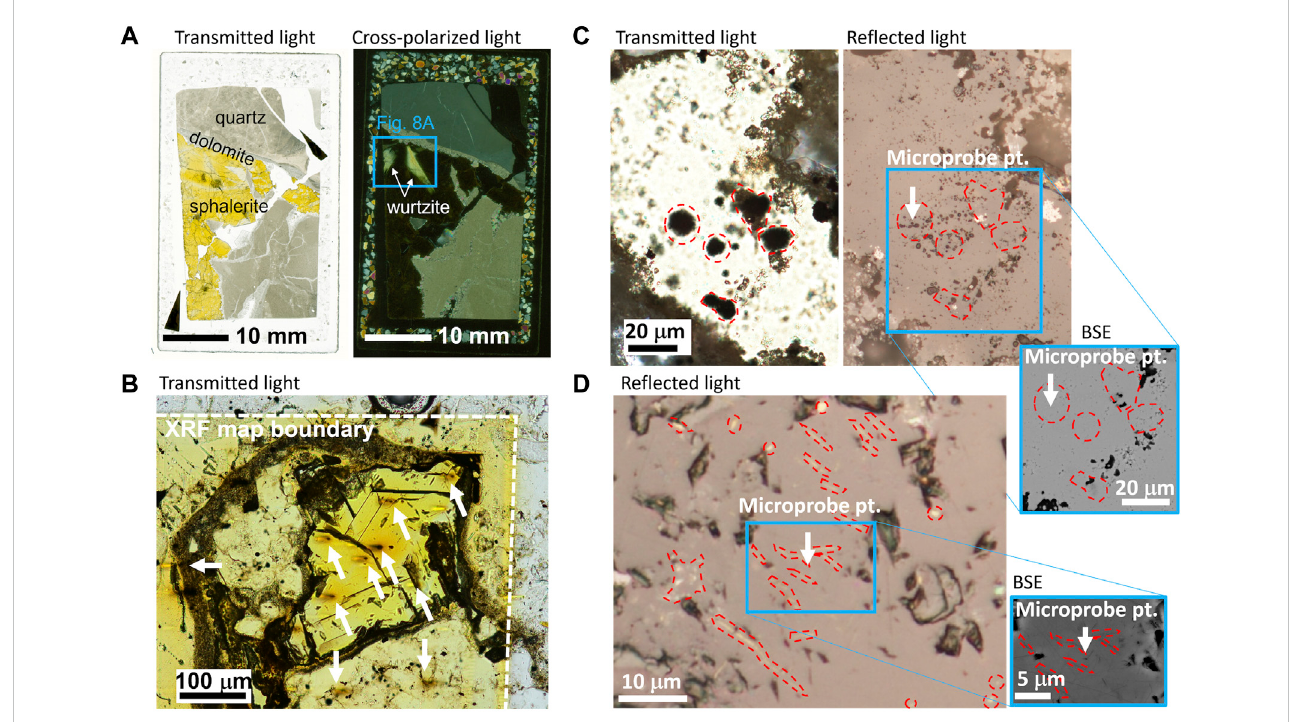
FIGURE 2 Applications of optical microscopy. (A) Transmitted light image showing the distribution of minerals in this sample. Sphalerite color varied from clear to golden yellow. A cross-polarized transmitted light image of the same sample revealed the distribution of anisotropic regions, which indicate the presence of non-cubic ZnS. (B) Transmitted light image collected post-synchrotron in order to document changes induced by the synchrotron X-ray beam. Note yellowing of the entire μ -XRF map region. Also note dark orange marks where XANES spectra were collected (white arrows). Although potentially indicatingbeamdamage,nochangeswereobservedinspectrawhenmultipleXANESscanswerecollected. (C) Transmittedlightimageshowingthepresence ofseveralsub-surfaceFe-rich inclusions, which werenot visiblein re fl ected lightorSEM-BSE(see BSE inset). These inclusionsexplainanomalouslyhigh Fein microprobe analysis (white arrow). (D) Re fl ected light image indicates the presence of chalcopyrite (brassy spots and strips typically oriented lower right to upperleft,someofwhich areoutlinedinred)within sphalerite.The chalcopyrite requiredhighcontrastsettingsintheSEM-BSEtoobserve (seeBSEinset),but explains the high Cu in microprobe analysis (white